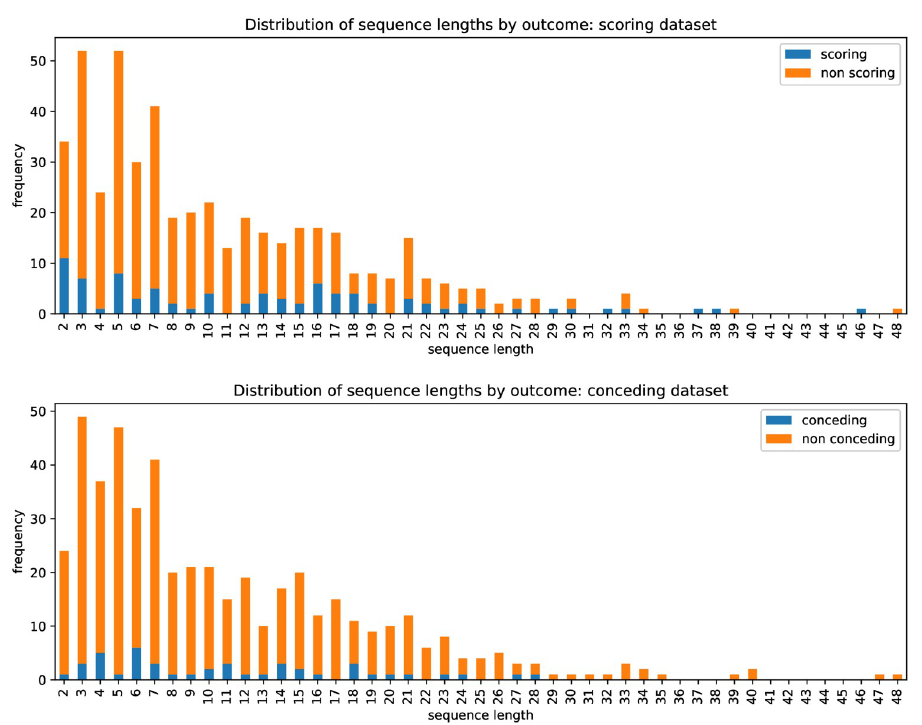
Fig 5. Sequence length distributions. Distribution of sequence lengths by points-scoring outcome for the scoring and conceding datasets. Sequence length is defined as the number of events in each sequence (excluding the outcome label).